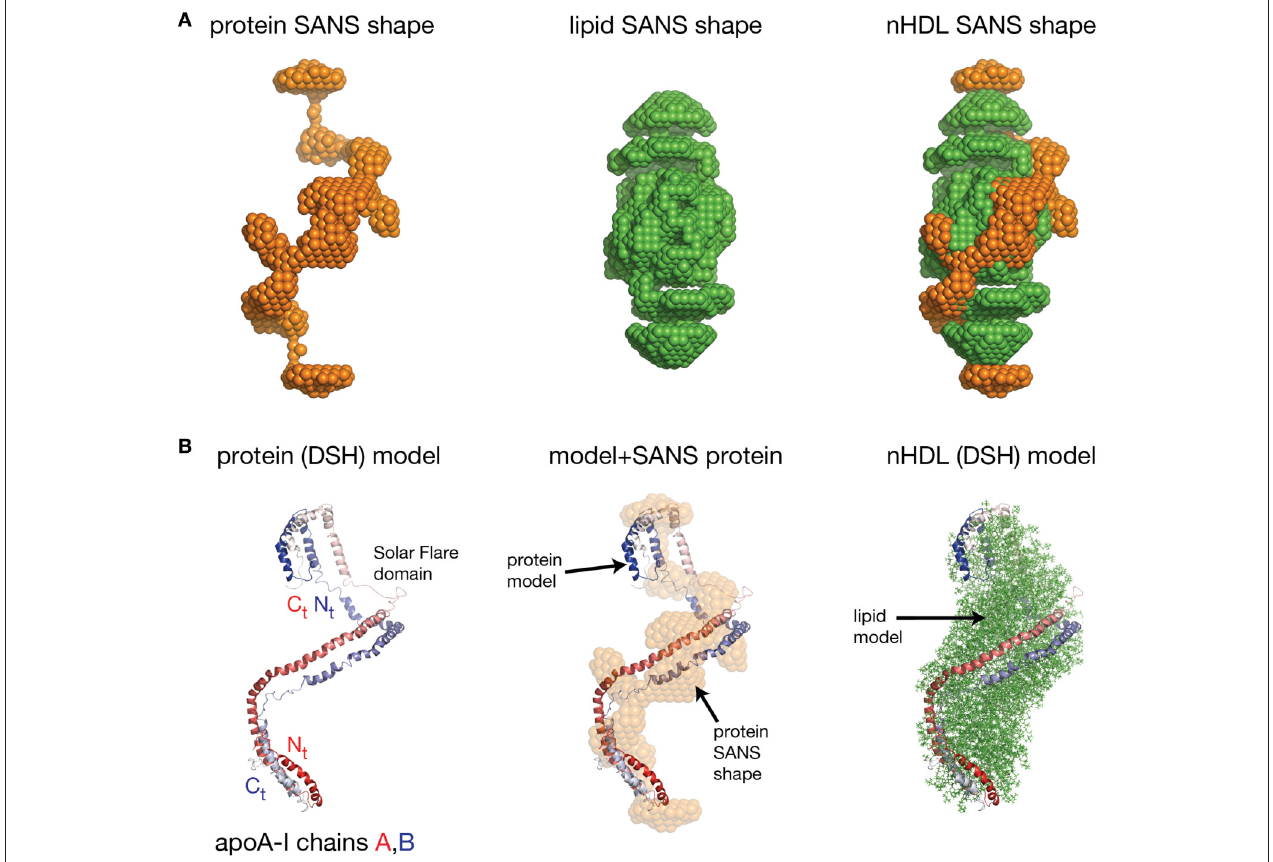
FIGURE 5 | The low resolution structure and the DSH model of nHDL reconstituted with POPC and FC. (A) Left: The low resolution structure of the protein component of nHDL. Middle: The low resolution structure of the lipid component of nHDL. Right: The low resolution structure of nHDL as a combination of the low resolution structures of the protein and lipid components of nHDL. (B) Left: the DSH model of the full length apoA-I dimer in nHDL proposed by Wu et al. (2009). The apoA-I chains shown in cartoon representation and colored with gradient red/blue, are oriented antiparallel in helix 5 registry. The Solar Flares domains introduced in the Solar Flares model of discoidal nHDL were retained in this model of nHDL to accommodate the HDX-MS data. Middle: Superposition of the spiral apoA-I double chain with the low resolution structure of the protein component of nHDL obtained by SANS with contrast variation. Right: The DSH model of nHDL; the lipid model was built from 200 POPC and 20 FC molecules in a combined micellar/lamellar phase. The lipids in close proximity to protein follow a lamellar arrangement while those further away are arranged radially (as in a micelle) in order to accommodate the open conformation of apoA-I and avoid exposing acyl chains to